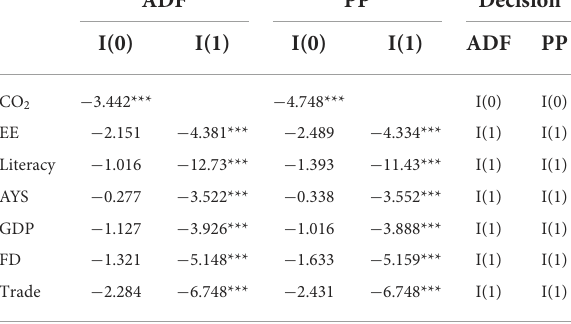
TABLE 2 Unit root